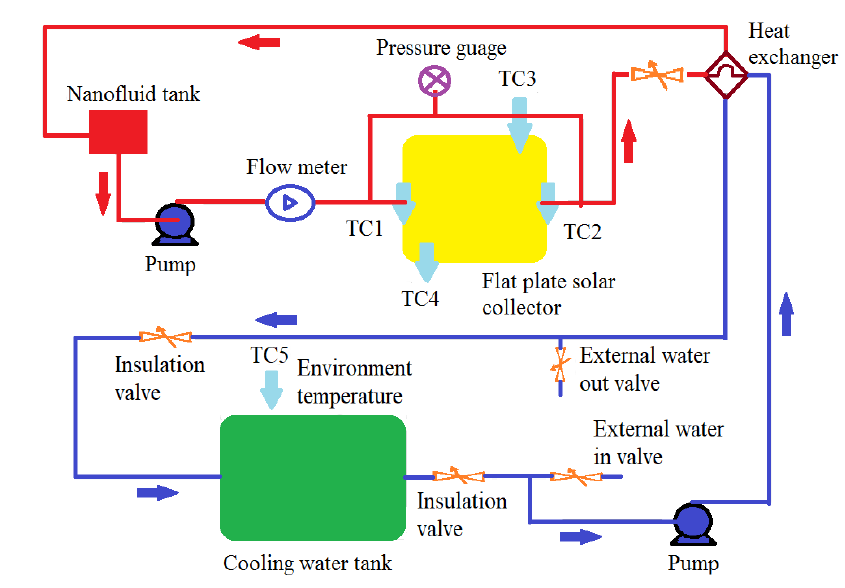
Fig. 3. Detail assembled diagram of solar collector, cooling water tank, and heat exchanger [8].